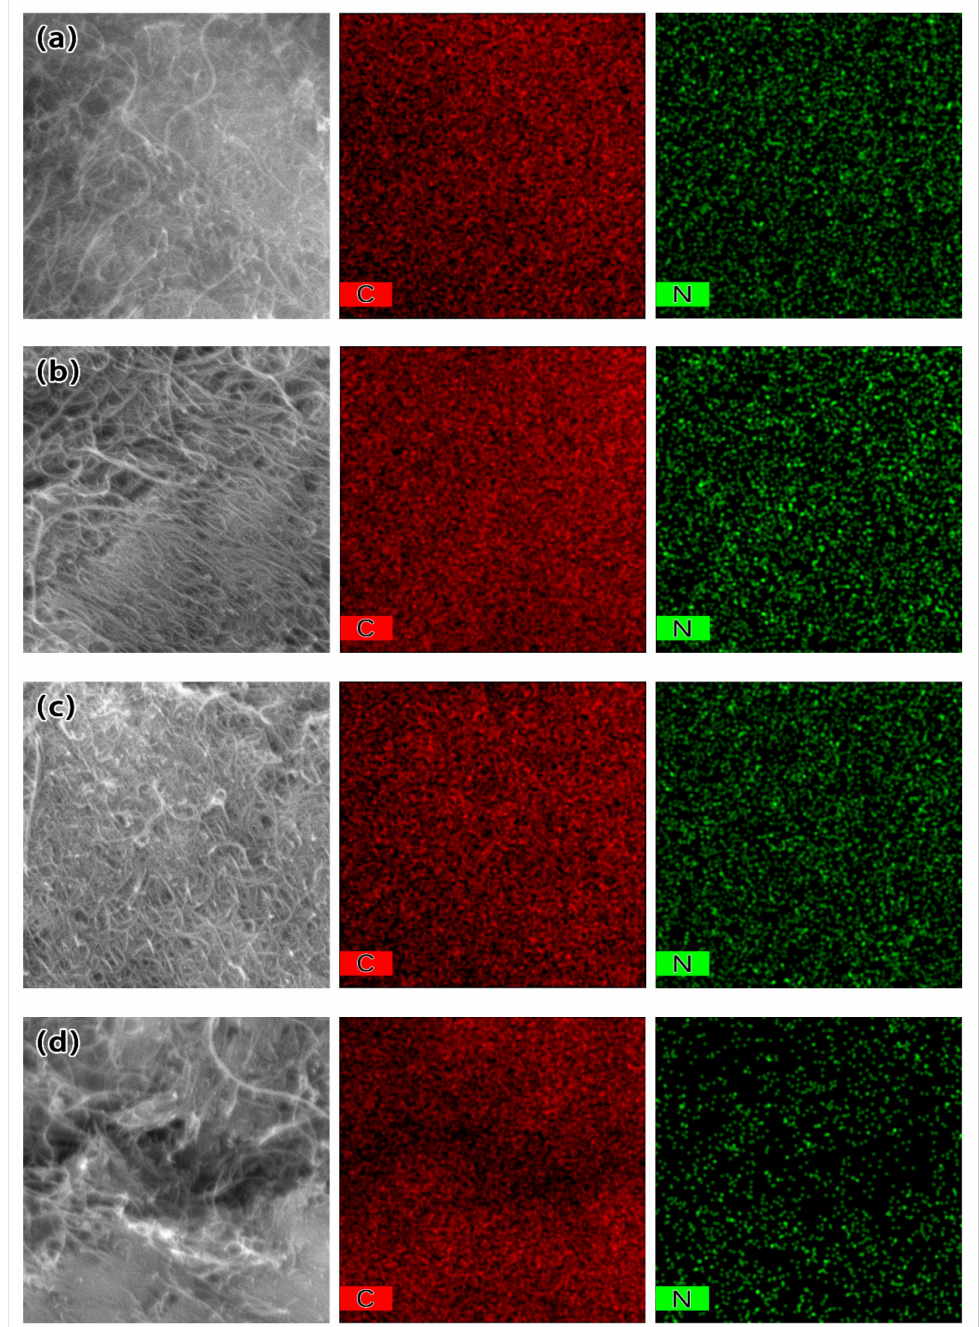
Figure 1. ( a – d ): SEM characterization (left side) and EDS measurements of the samples ( a ) NCNT-700, ( b ) NCNT-800, ( c ) NCNT-900, and ( d ) NCNT-1000 (middle and right